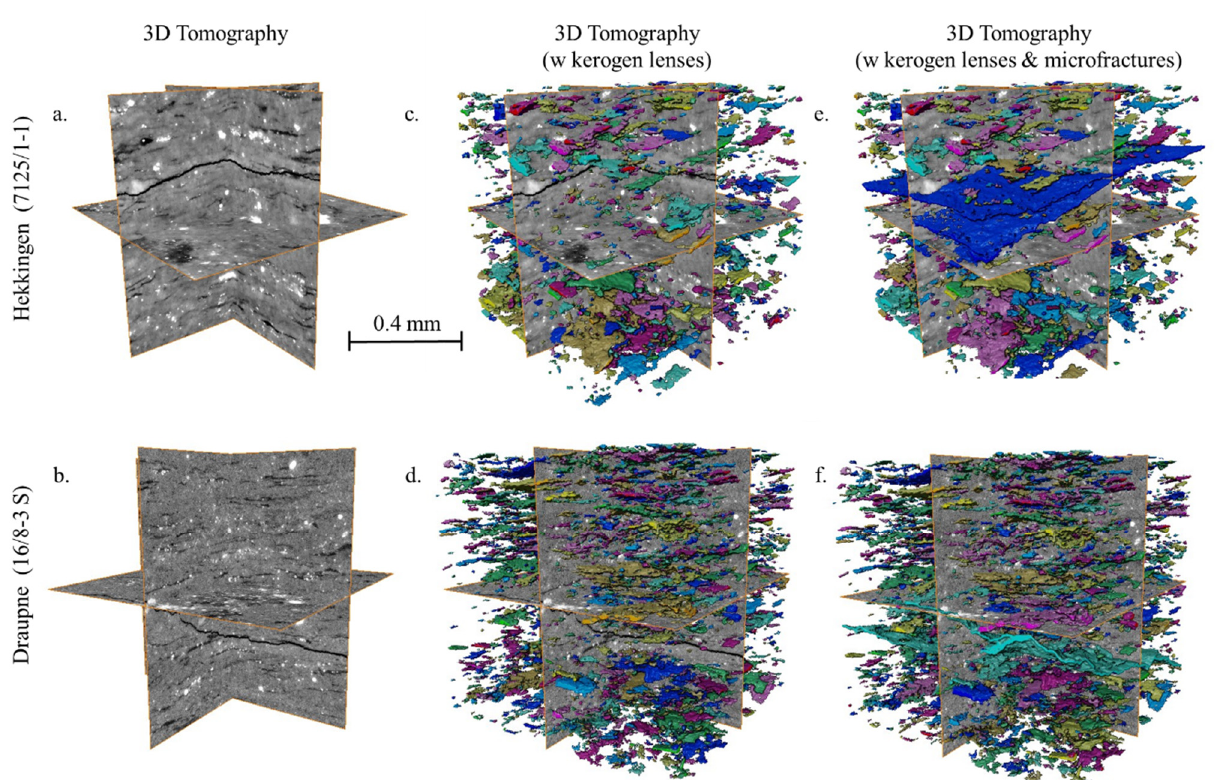
Figure 11. 3D tomographical images at 0.7 µm/voxel from both the Draupne (16/8-3 S) and Hekkingen Formations (7125/1-1). ( a , b ) Grayscale orthoslices highlighting fractures and kerogen lenses in black, ( c , d ) with 3D realization of just kerogen lenses, and ( e , f ) 3D realizations of kerogen lenses and branching microfractures.